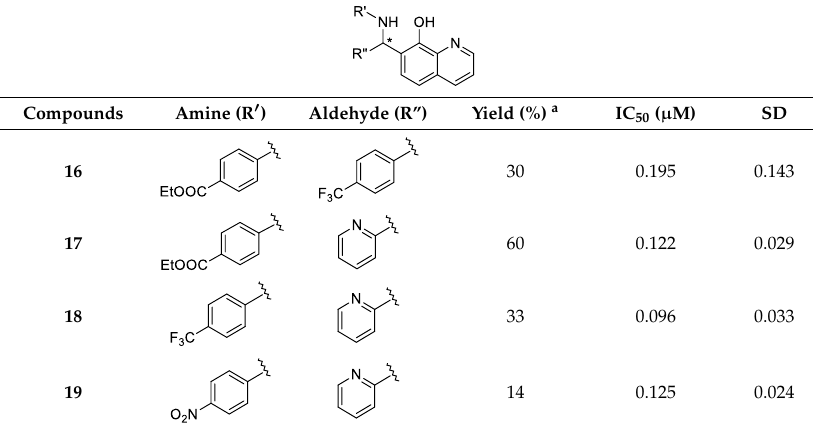
Table 1. Betti-three components reactions (3CR) results, use of several anilines and aldehydes (Subclass 1).